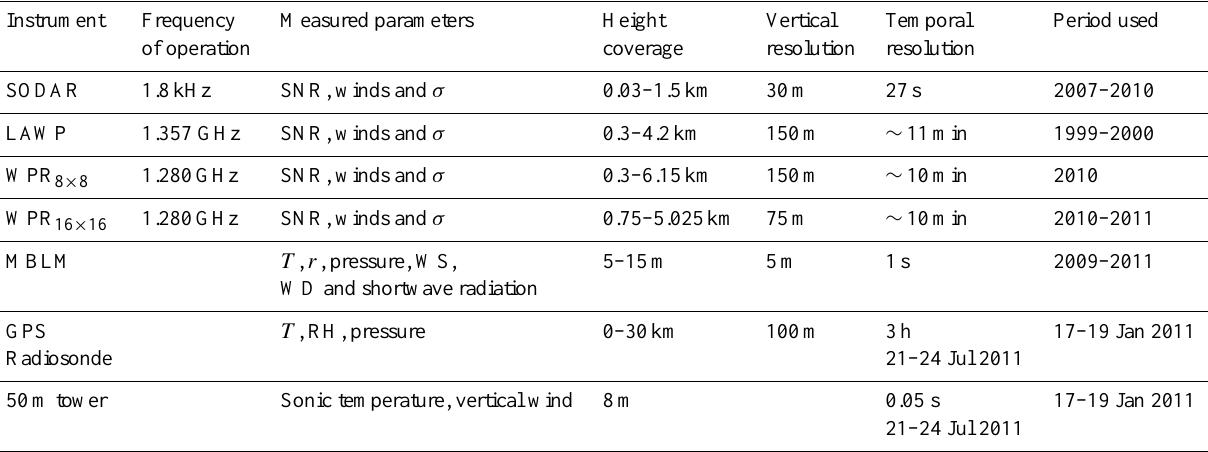
Table 1. Instruments used in the integrated approach, their operating frequency, height coverage, vertical and temporal resolutions and duration of data.